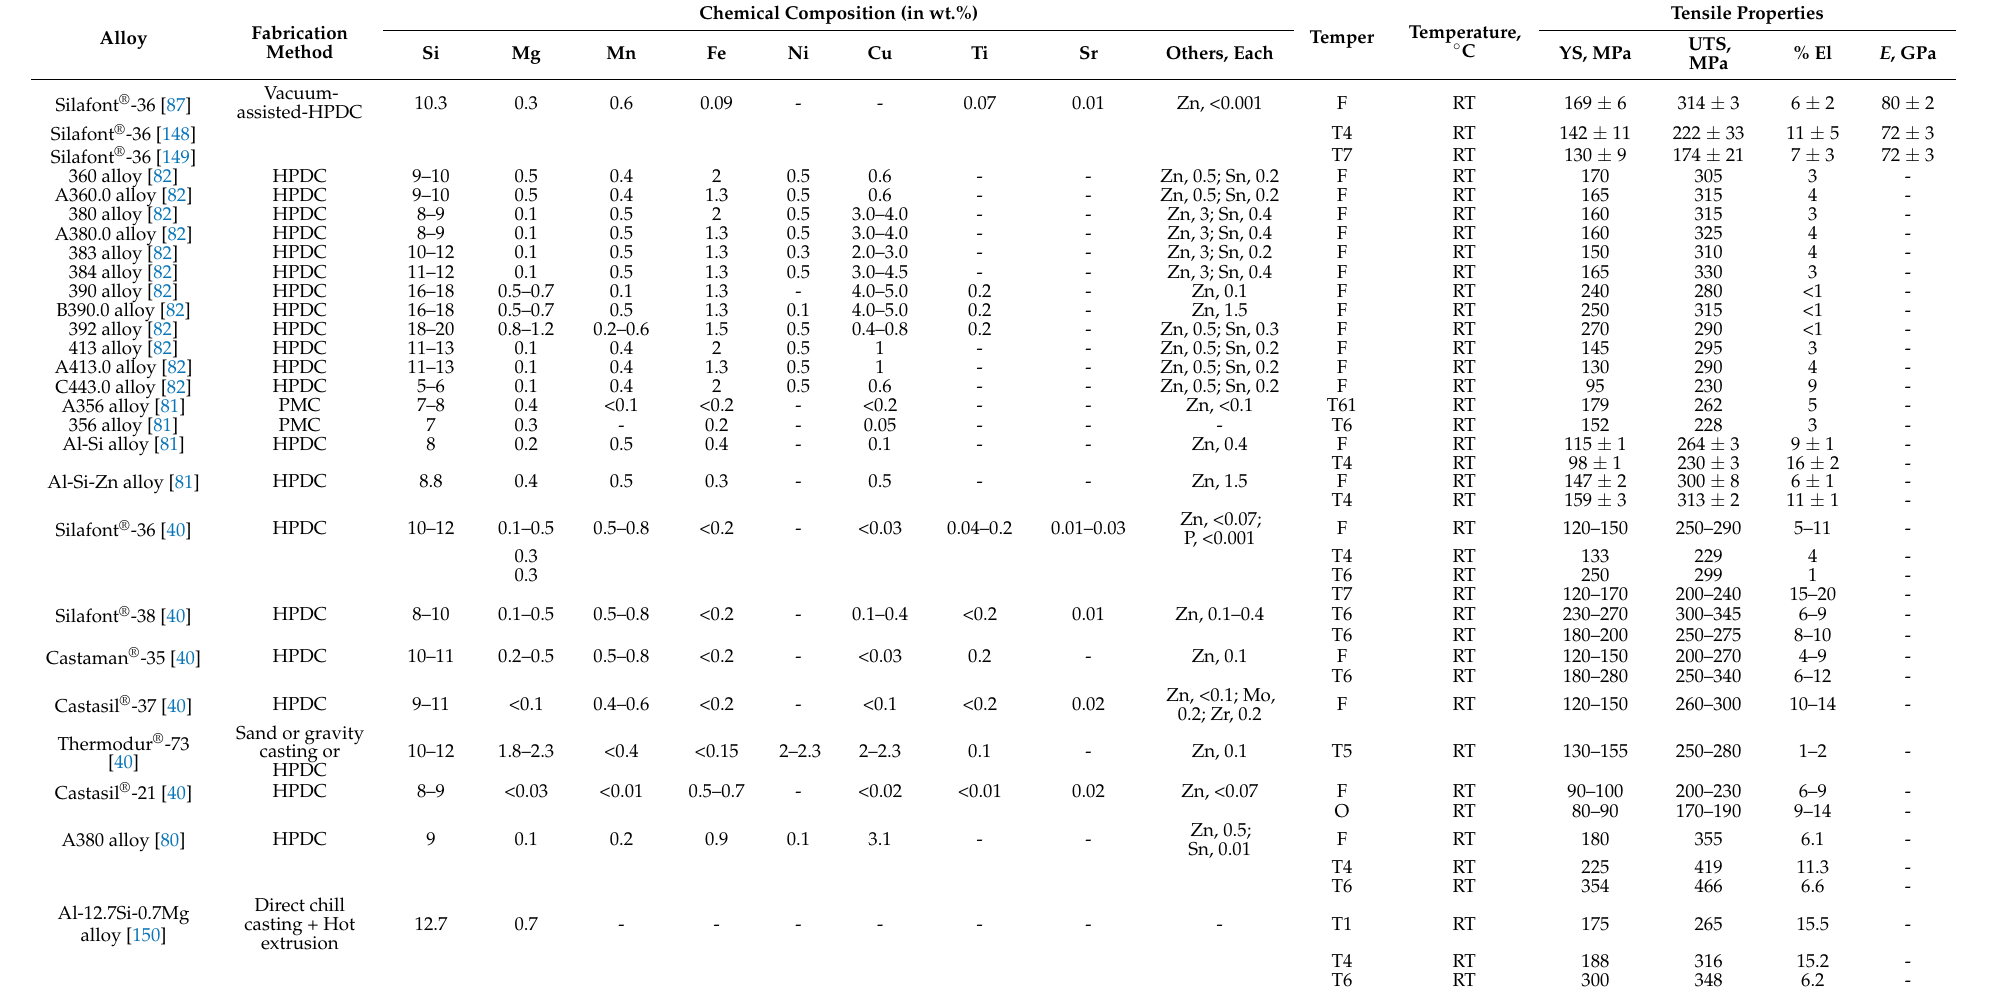
Table 3. Chemical composition and tensile properties of structural Al-Si